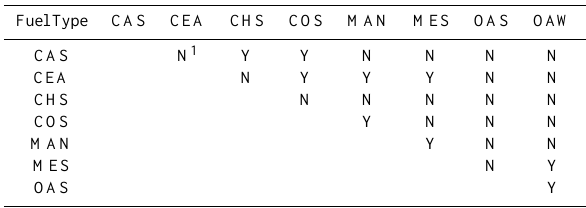
Table 4. Species effects on particle size